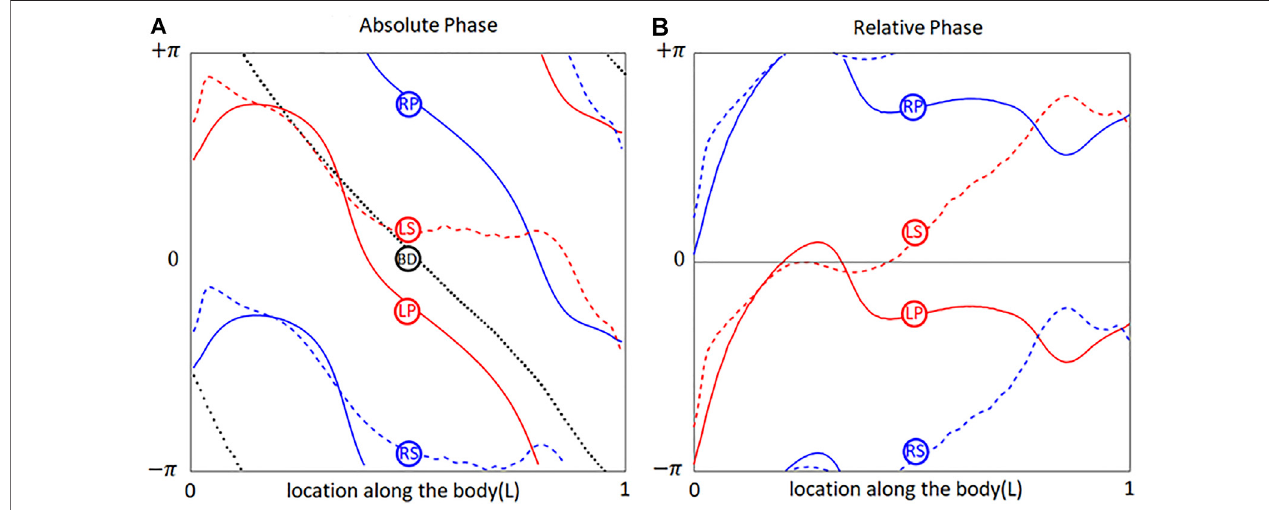
FIGURE2| Phasesof k =1ACcomponentofrespectivelybodydeformation(BD),leftlateral-linepressure(LP),rightlateral-linepressure(RP),leftlateral-lineshear- stress (LS), right lateral-line shear-stress (RS). (A) Absolute values; (B) Relative values about the body deformation phase.